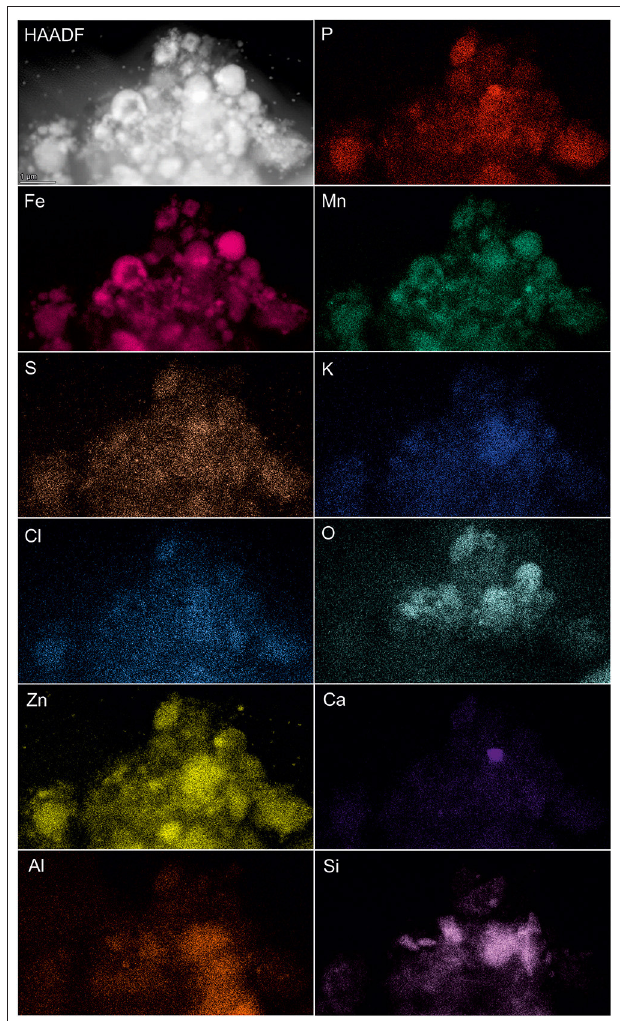
FIGURE 7 | Elemental ultrastructural analysis of microbial-mineral assemblages formed in cultures of A. manzaensis grown on BOF-dust. HAADF-STEM image of a microbially processed sample used for the EDS spectrum image acquisition and corresponding elemental distribution maps of phosphorus (P), iron (Fe), manganese (Mn), sulfur (S), potassium (K), chlorine (Cl), oxygen (O), zink (Zn), calcium (Ca), aluminum (Al), carbon (C), nitrogen (N), and silicon